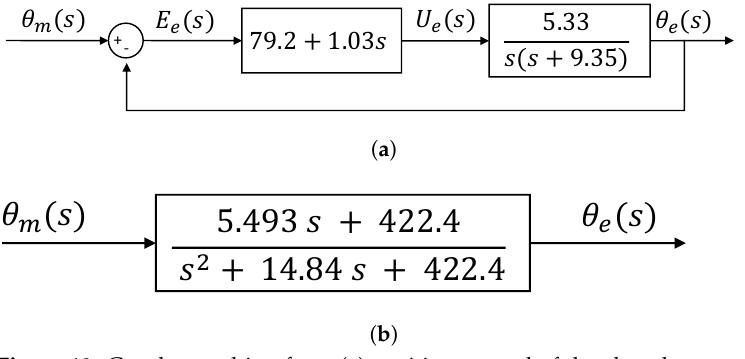
Figure 18. Graphs resulting from ( a ) position control of the slave loop motor axis and ( b ) control voltage resulting from the calculated PD.